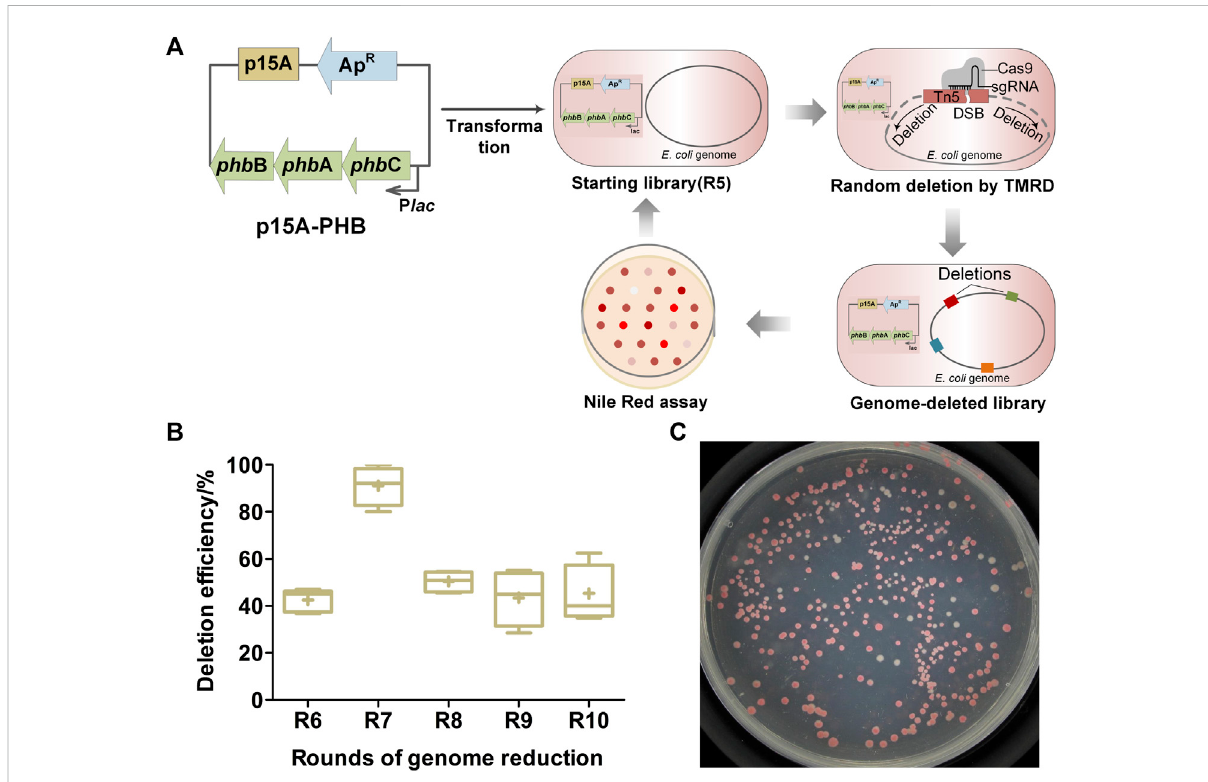
FIGURE 1 Random reduction of E. coli genome for PHB accumulation by transposon-mediated random deletion (TMRD) strategy. (A) Diagram of the coupledrandomgenomereductionwithPHBaccumulation.Abbreviations: phb A, β -ketoacyl-CoAthiolasegene; phb B,acetoacetyl-CoAreductase gene; phb C, PHB polymerase gene; Ap R , ampicillin resistance gene; P lac , Lac promoter. DSB, double-strand break; sgRNA, sing-guide RNA. (B) Deletion ef fi ciency of different TMRD cycles. Center lines show the medians. “ + ” represents the means. Box limits indicate the fi rst and third quartiles. Whiskers show the maximum and minimum values. Six replicates were performed. At least 24 colonies were selected randomly in every replicate. (C) Screening of PHB competent cells by Nile red